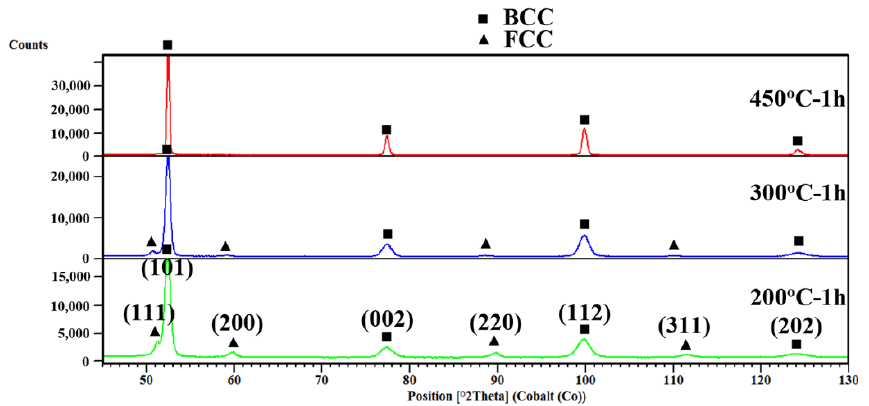
Figure 14. XRD pattern recorded for both the Q&B and Q&P specimens at different temperatures between 450 and 200 °C for 1 h isothermal holding. Table 4. The average RA phase fractions and their carbon contents in the case of Q&B (450, 400, 350, 300 °C) and Q&P (250, 200 °C) specimens held for 1 h .